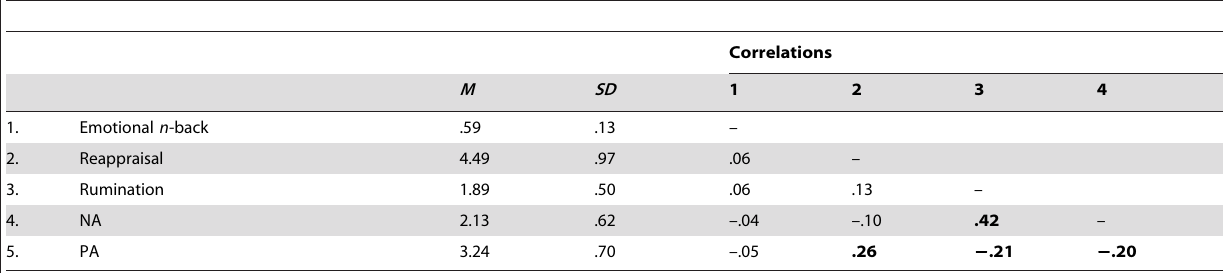
Table 2. Descriptive Statistics and Relationships of Different Variables in Study 1.